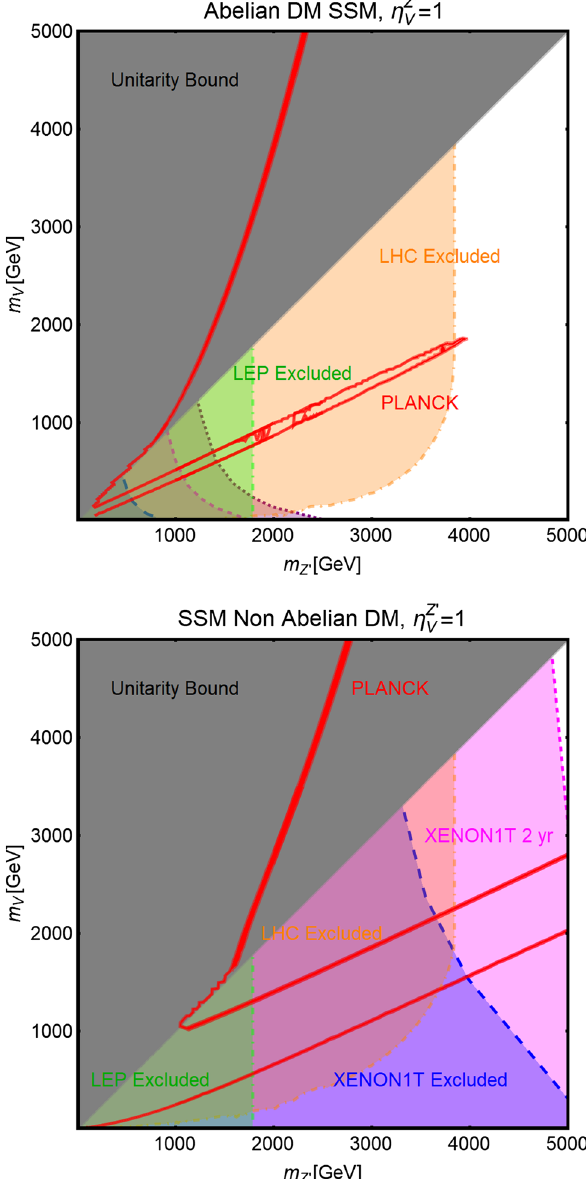
Fig. 15 Combined constraints in the m Z (cid:15) , m V bi-dimensional plane for Abelian (top panel) and non-Abelian (bottom panel) vectorial DM interacting with a Z (cid:15) mediator, for the choice of η Z (cid:15) we have chosen SSM couplings of the Z (cid:15) with the SM fermions (see Table 1). Colour scheme is the same as Fig.